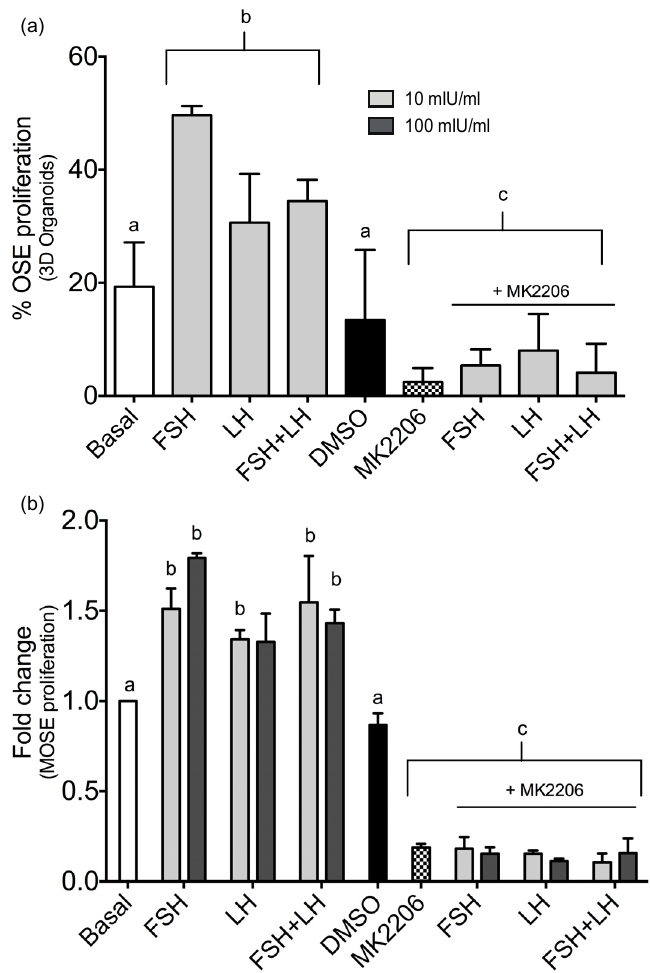
Figure 3. Inhibition of Akt signaling decreases gonadotropin regulated OSE